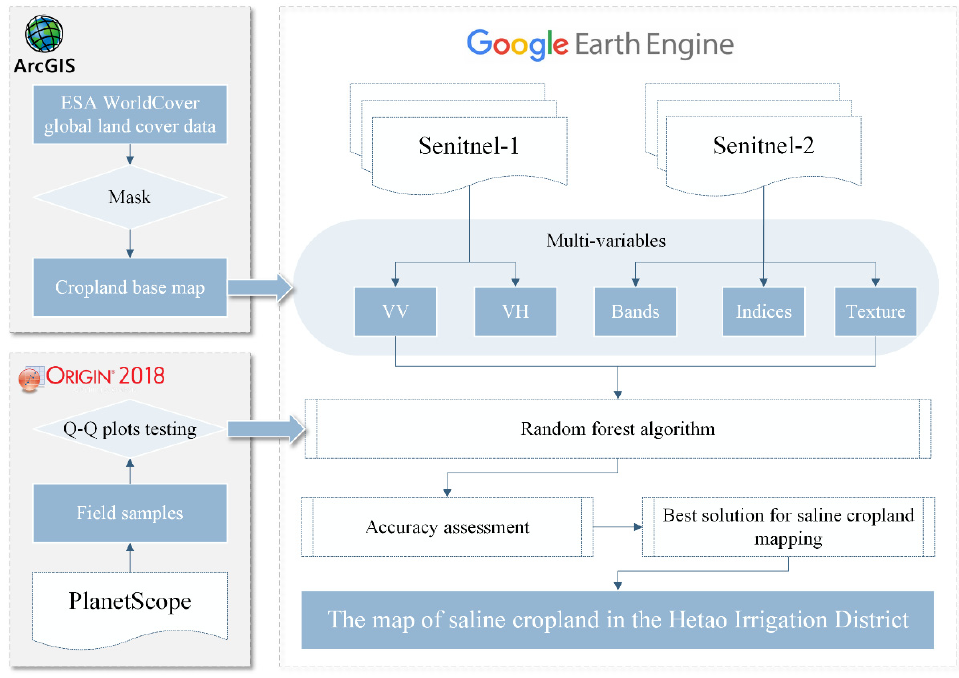
Figure 3. Technical framework of this